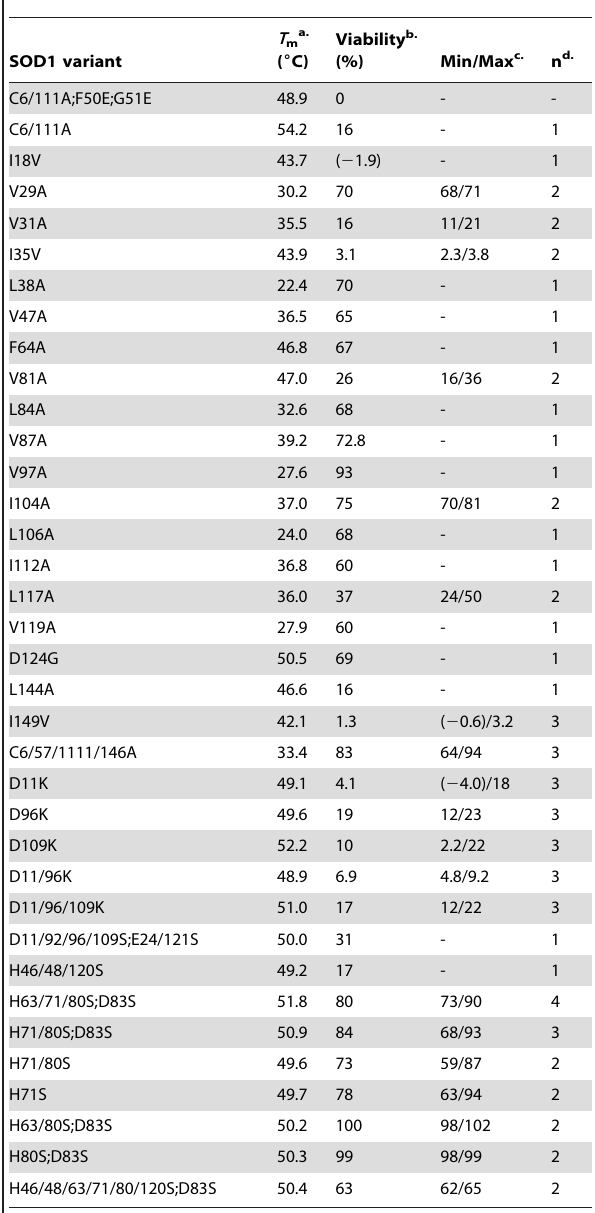
Table 1. Melting temperature ( T m ) and cell viability of apoSOD1 protein variants.